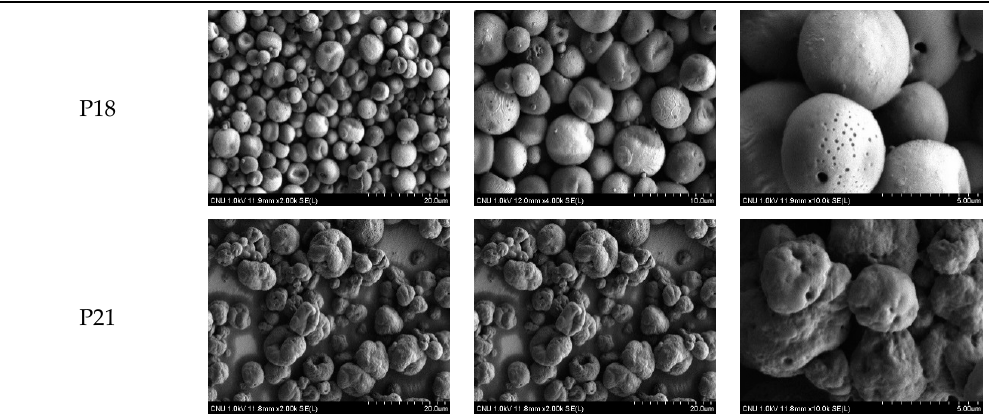
Figure 1. SEM image of spray-dried olive oil powder, P8, P16, P18, and P21 . P18 showed the spherical shape with many pores but its surface was smooth.